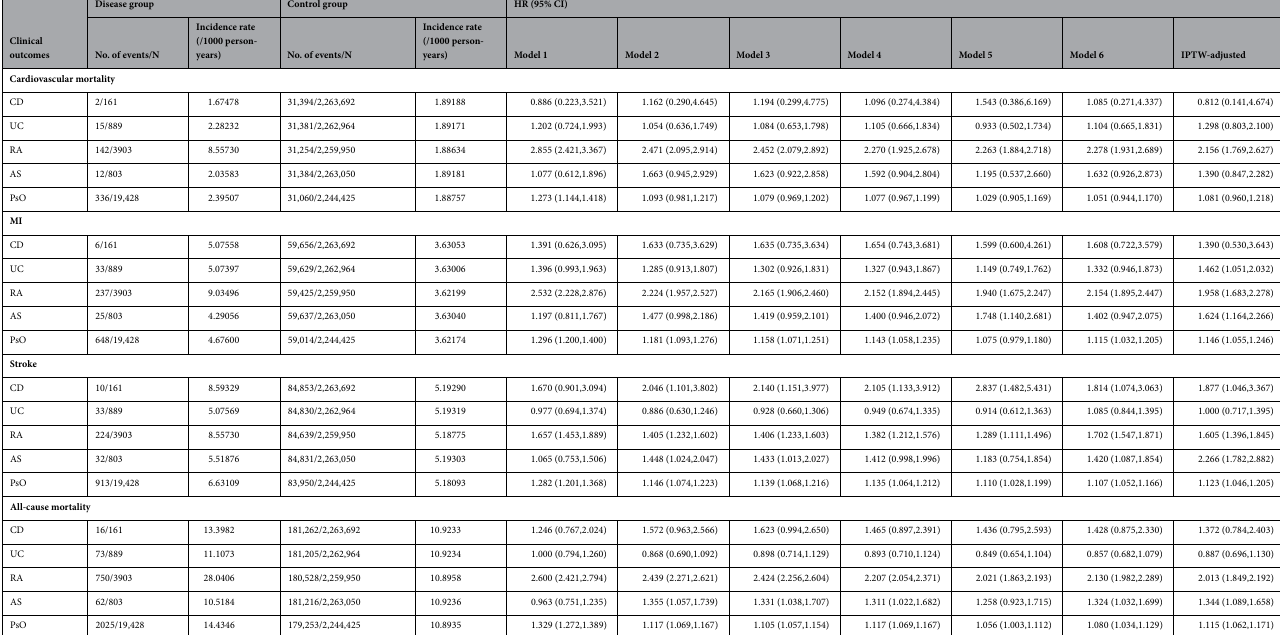
Table 2. Clinical outcomes according to the presence of immune-mediated inflammatory diseases. HR hazard ratio, CI confidence interval, CD Crohn’s disease, UC ulcerative colitis, RA rheumatoid arthritis, AS ankylosing spondylitis, PsO psoriasis, MI myocardial infarction, IPTW inverse probability of treatment weighting. Model 1 adjusted for none of the covariates (univariable analysis). Model 2 adjusted for age and sex. Model 3 adjusted for age, sex, smoking, alcohol consumption, and regular physical activity. Model 4 adjusted for age, sex, smoking, alcohol consumption, regular physical activity, hypertension, dyslipidemia, and BMI. Model 5 adjusted for age, sex, smoking, alcohol consumption, regular physical activity, hypertension, dyslipidemia, BMI, use of insulin, number of oral hypoglycemic agent ≥ 3, duration of type 2 diabetes ≥ 5 years, and depression. Model 6 adjusted for age, sex, smoking, alcohol consumption, regular physical activity, hypertension, dyslipidemia, BMI, use of insulin, number of oral hypoglycemic agent ≥ 3, duration of type 2 diabetes ≥ 5 years, depression, waist circumference, fasting glucose, systolic BP, diastolic BP, total cholesterol, LDL-cholesterol, and